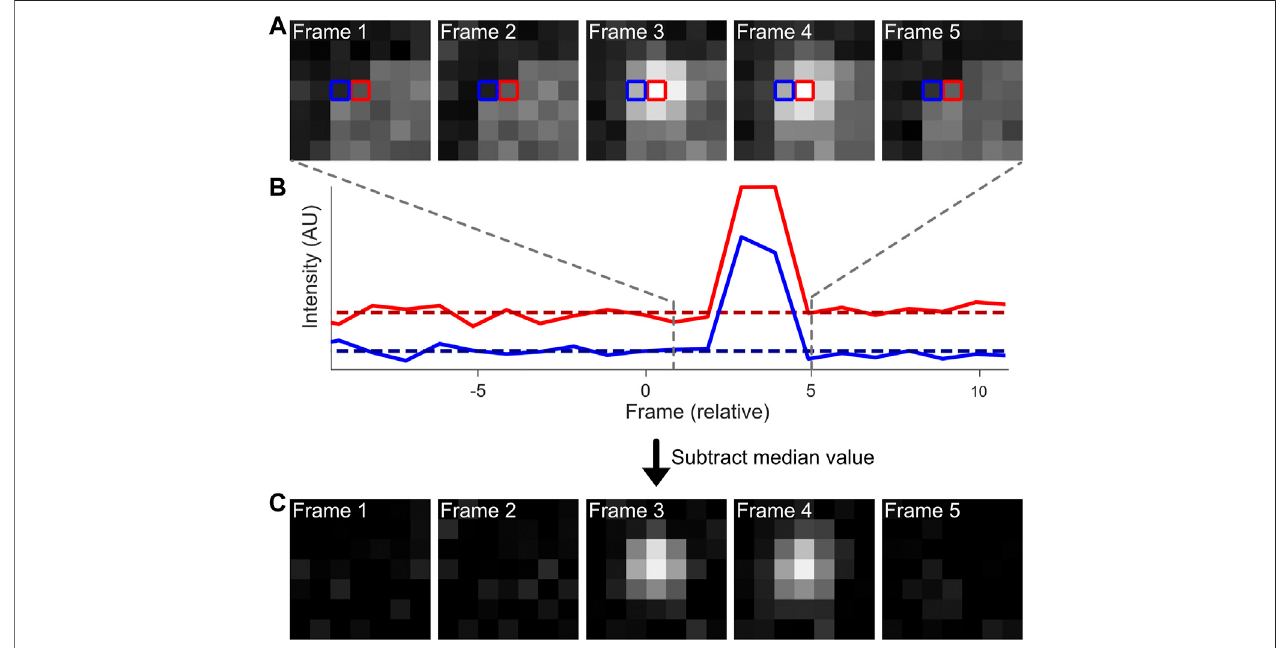
FIGURE 1 | Computational work fl ow of a temporal median fi lter. Fluorescence emissions from individual, blinking fl uorophores are often present on top of an inhomogeneous background (A) . The intensities of individual pixels can be analysed over a period of time [ (B) , solid lines]. The median intensity value per pixel (dotted lines) can be extracted and subtracted from the original intensity data to adequately remove the background from the dataset (C)